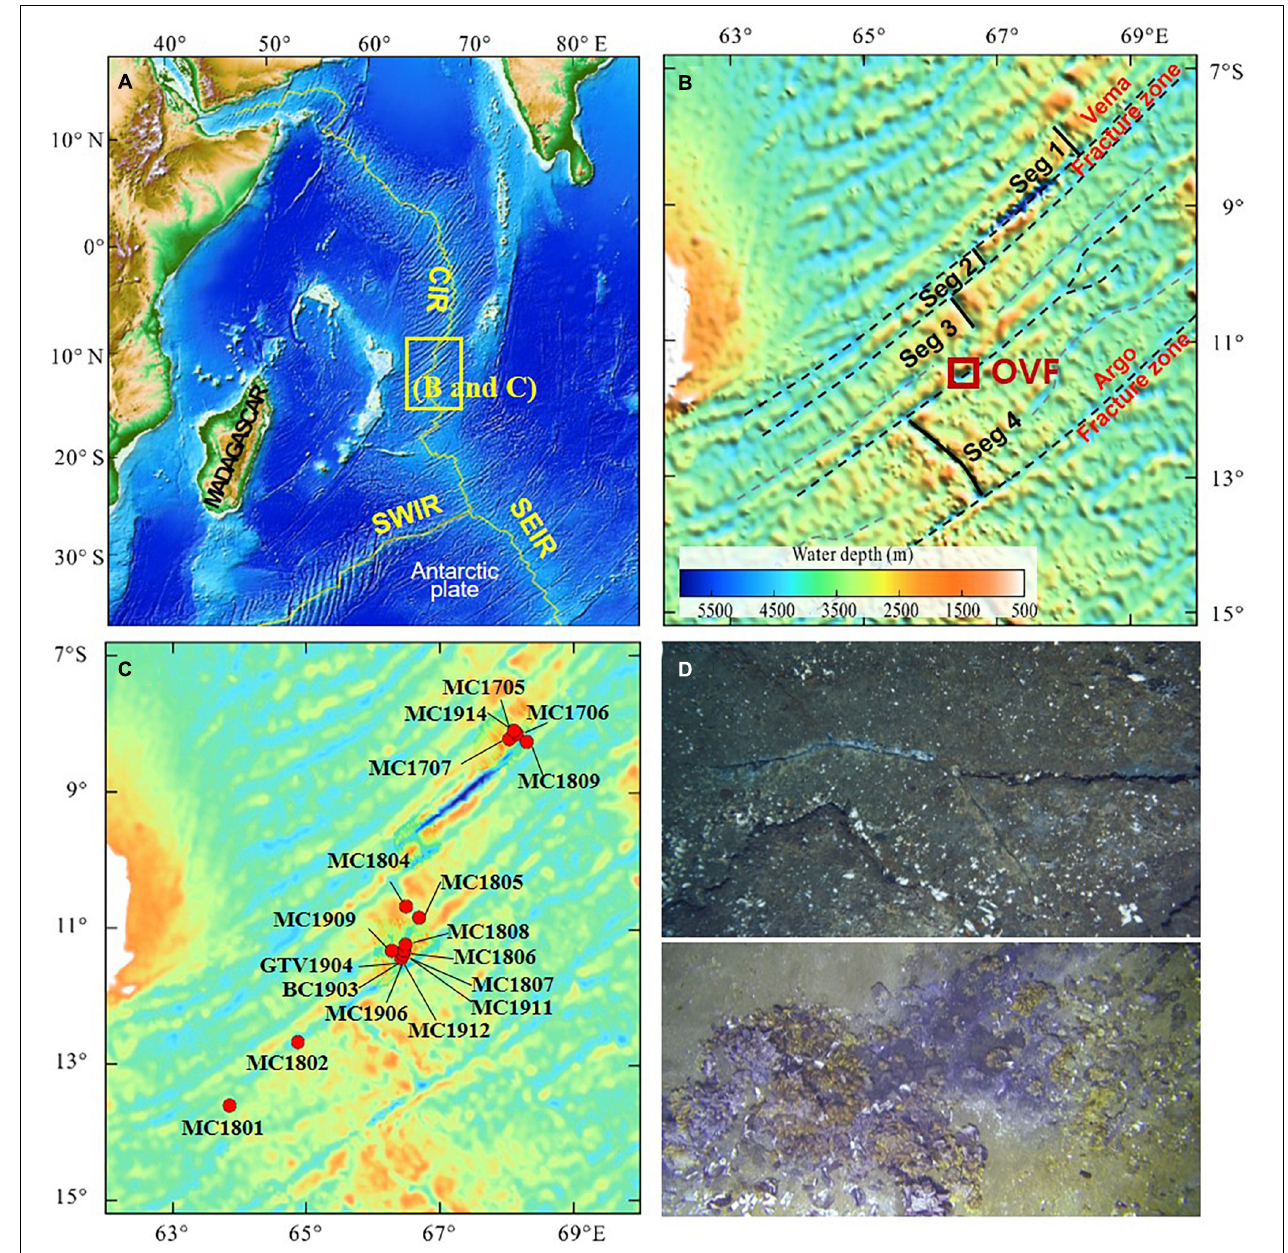
FIGURE 1 | (A) Map showing the Indian Ocean ridges and (B) the location of the Onnuri hydrothermal vent field (red square) and (C) sampling sites. (D) Photographs showing zonation of the active OVF (Widths of photographs are ∼ 6 m, Kim et al., 2020). Note the fissures filled with vent fauna indicating possible diffuse flow and the clusters of various living vent fauna. CIR, Central Indian ridge, SWIR and SEIR, Southwestern and Southeastern Indian ridge; OVF, Onnuri hydrothermal vent